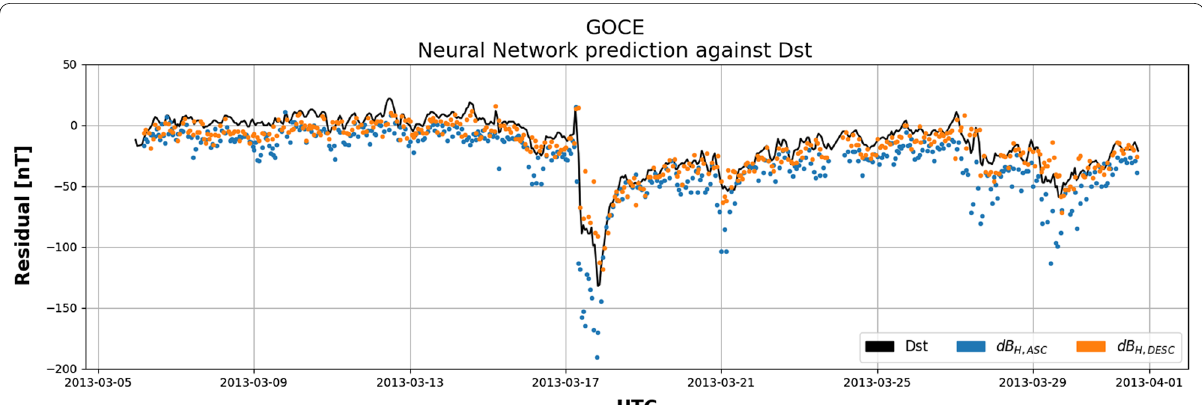
Fig. 9 Magnetic storm in March 2013 indicated by Dst index. The variations of the residual values of the calibrated GOCE platform magnetometer to the CHAOS‑7 core and lithospheric field for the ascending, dB H , ASC (blue) and descending, dB H , DESC (orange) orbits follow the index line well, with some known offsets